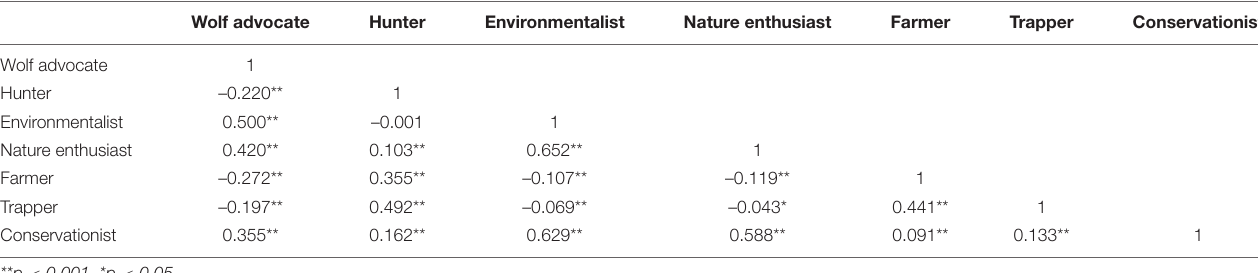
TABLE 2 | Bivariate correlations among identities for wolf stakeholders in Minnesota, United States.